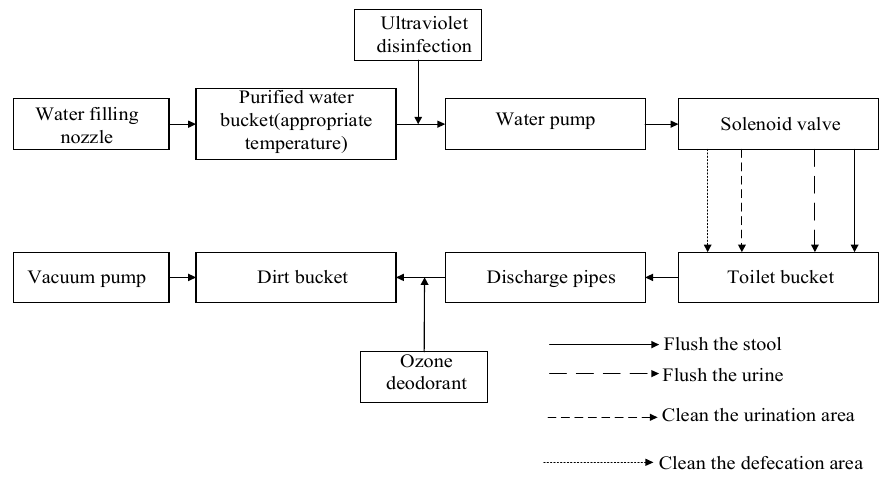
Figure 5. Component connection.